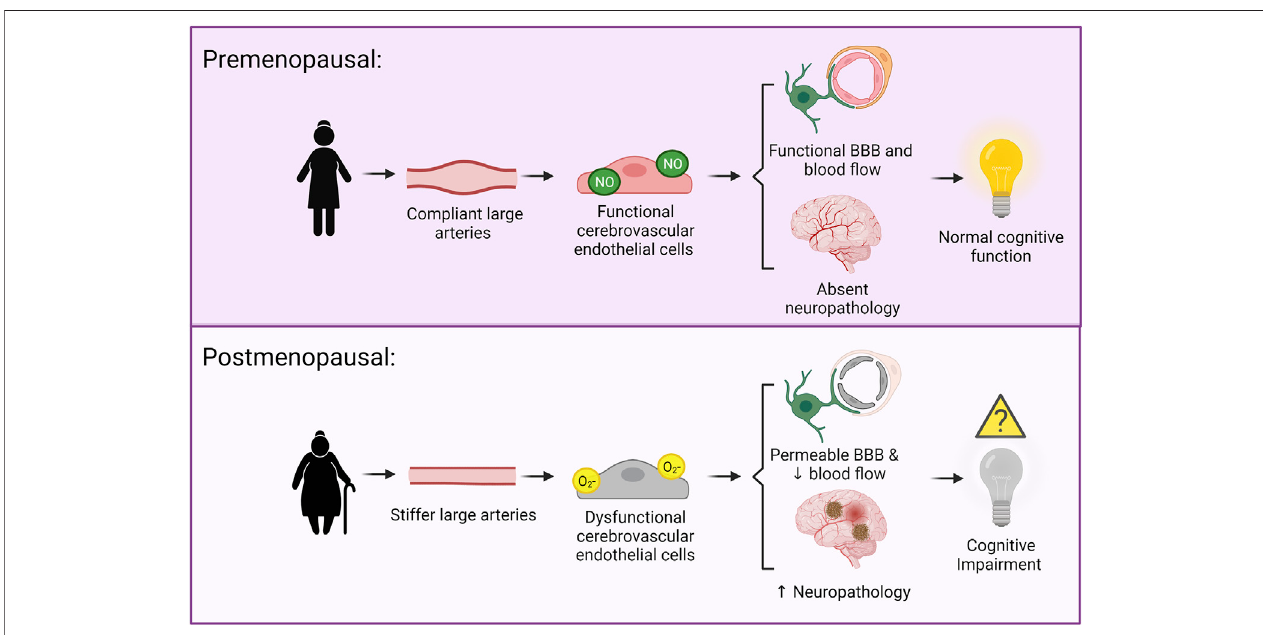
FIGURE 1 | Hypothesized mechanisms linking large artery stiffness and cognitive impairment. Above: In premenopausal females, the large arteries are compliant and cerebral pressure and blood fl ow pulsatility is low. This is associated with functional cerebral endothelial cells, a functional blood brain barrier, adequate cerebral blood fl ow, and an absence of neuropathology. Below: In postmenopausal females, there is greater large artery stiffness and higher cerebral pressure and blood fl ow pulsatility. This is associated with dysfunction of the cerebral endothelial cells, a more permeable blood brain barrier, neurovascular uncoupling, reduced cerebral blood fl ow, and increased